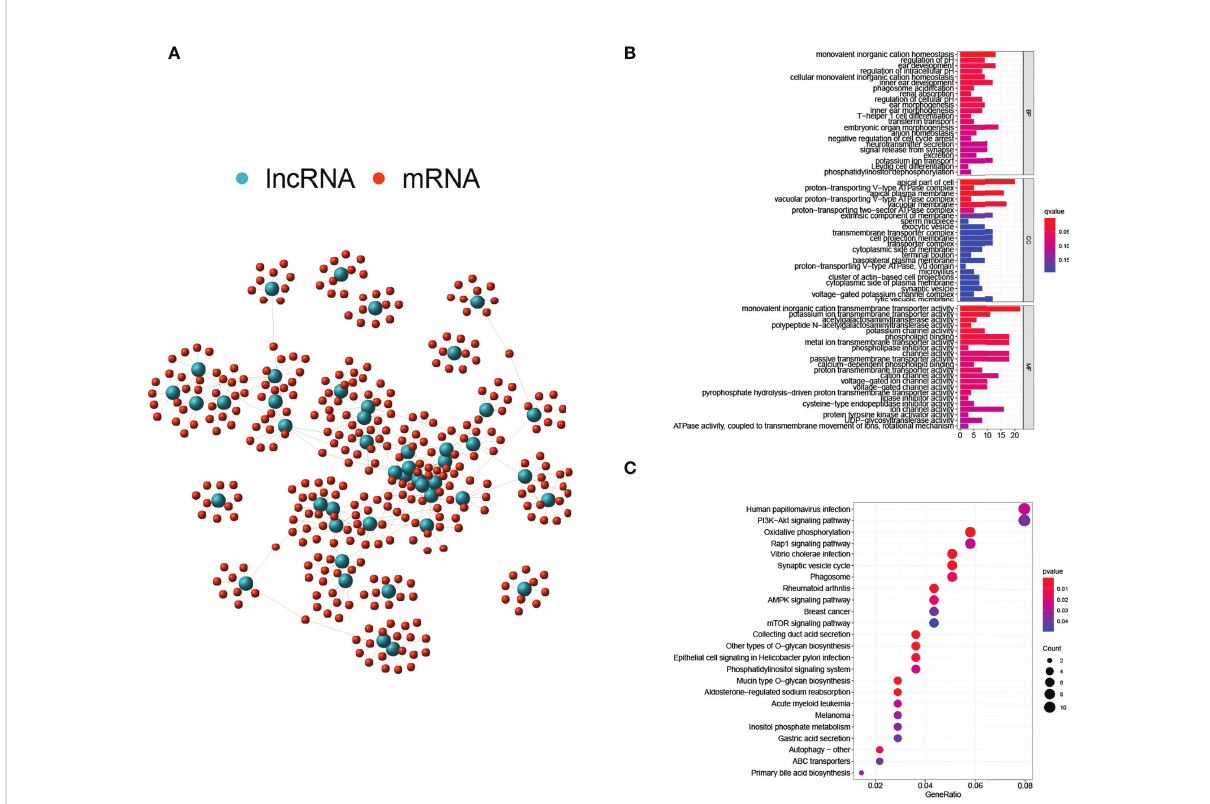
FIGURE 3 Regulatory network and functional analyses. (A) Co-expression network of GILnc and targeted mRNAs. (B) Bar plots of GO terms enrichment analysis. (C) The bubble plot of KEGG pathway enrichment